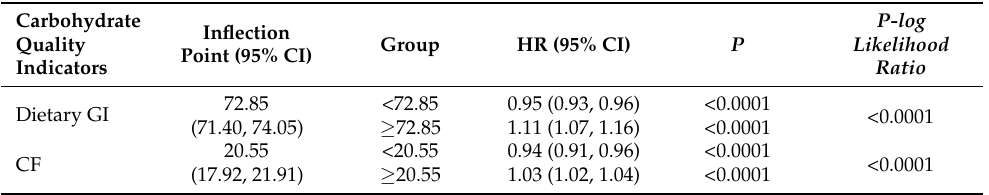
Table 4. Threshold analyses of the associations between dietary GI and CF and T2DM risk in 14,590 Chinese adults of the China Health and Nutrition Survey 1997–2015 1 .